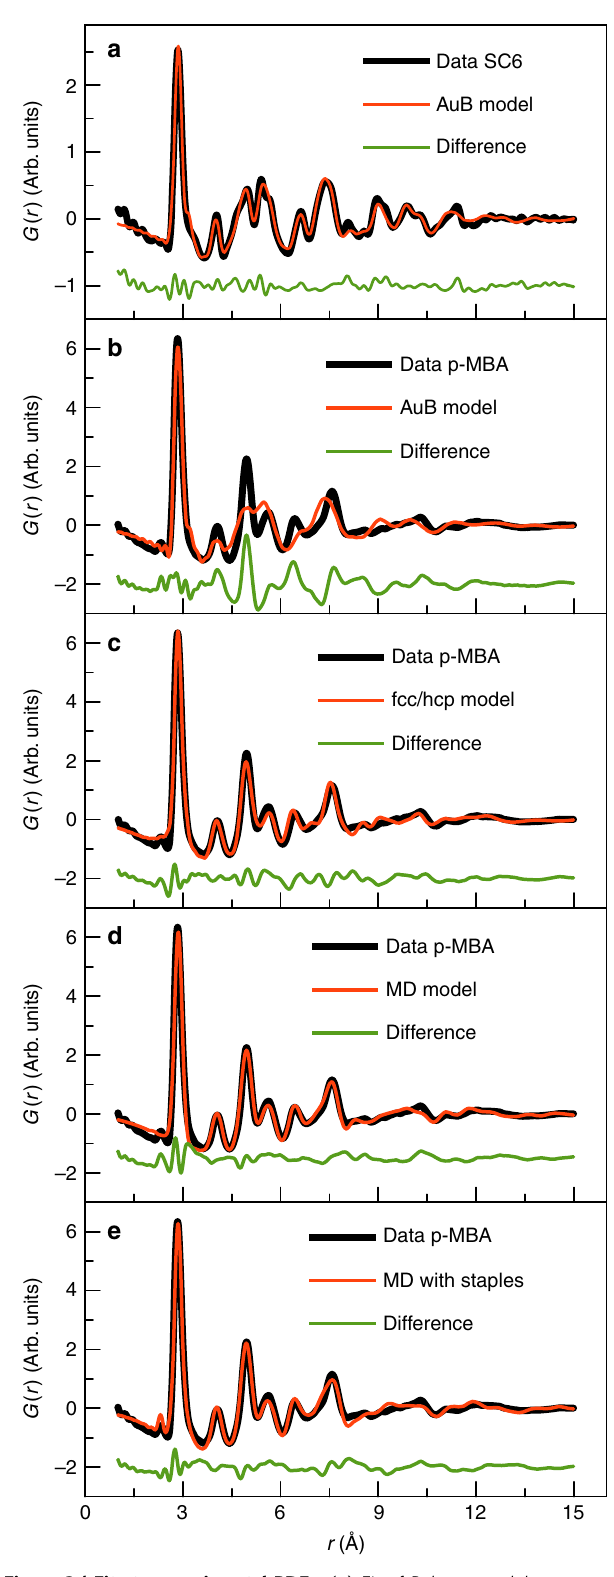
Figure 3 | Fits to experimental PDFs. ( a ) Fit of Bahena model to Au 144 (SC6) 60 data. ( b ) Fit of icosahedral model to Au 144 ( p -MBA) 60 data. ( c ) Fit of fcc/hcp model to Au 144 ( p -MBA) 60 data. ( d ) Fit of 114 atom decahedral model to Au 144 ( p -MBA) 60 data. ( e ) Fit of decahedral model with staples to Au 144 ( p -MBA) 60